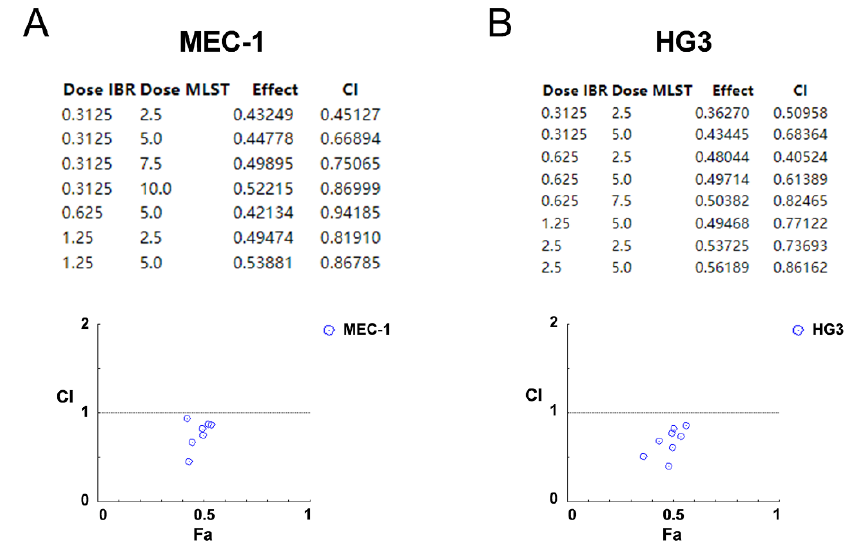
Figure 9. Synergistic effects of molidustat and ibrutinib. ( A ) Synergistic cytotoxicity of molidustat and ibrutinib on MEC-1 cells. The table shows the cell viability and synergistic index for each combination of molidustat and ibrutinib at different concentrations. The vertical axis in the dot plot is the cytotoxicity (CI) index, with values less than 1 indicating synergistic cytotoxicity of the two drugs at this concentration. ( B ) Synergistic cytotoxicity of molidustat and ibrutinib on HG3 cells. The table shows the cell viability and synergistic index for each combination of molidustat and ibrutinib at different concentrations. The vertical axis in the dot plot is the CI index, with values less than 1 indicating synergistic cytotoxicity of the two drugs at this concentration.